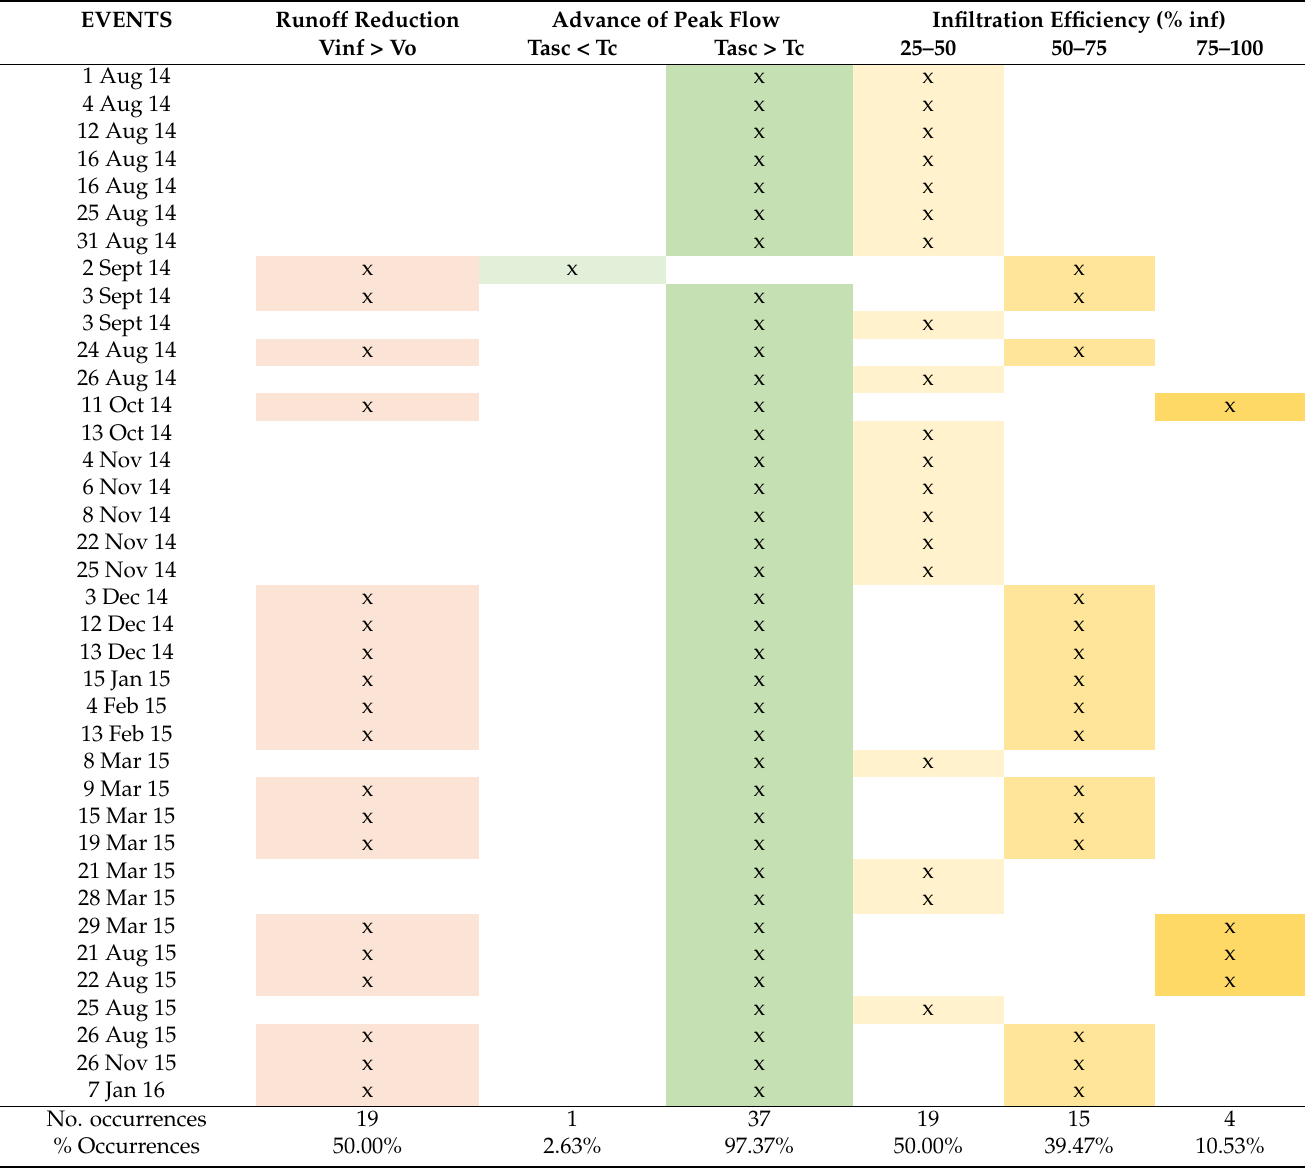
Salmon colored lines represent good runoff control; dark green indicates retardation in peak flow; infiltration efficiency is shown yellow, light yellow for 25 to 50% infiltration, medium yellow for 50 to 75% infiltration and strong yellow for 75 to 100%